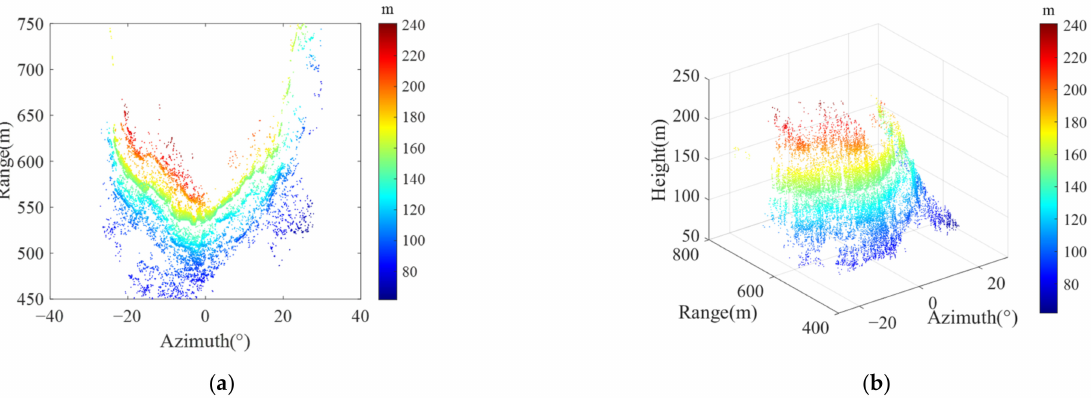
Figure 7. The height of all PSs. ( a ) Top view. ( b ) 3-D view.